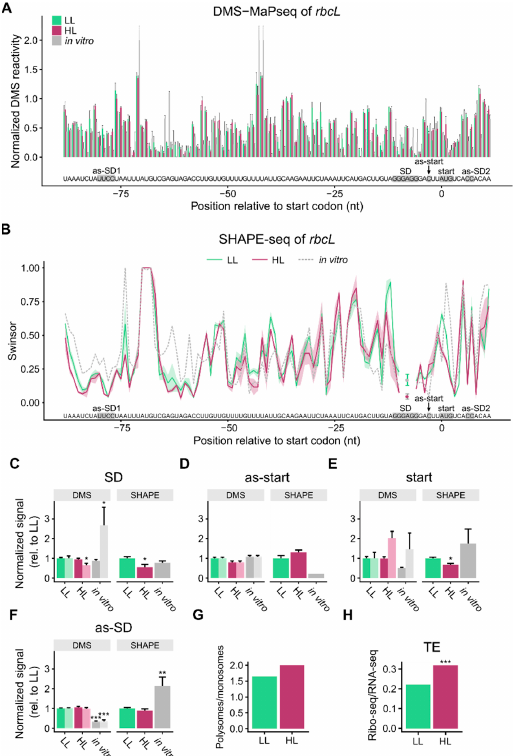
Figure 3. mRNA secondary structure changes in the translation initiation region of rbcL : ( A ) DMS probing of RNA from young, 17–18-days-old plants exposed to low light (LL, light green), high light (HL, dark red), and of in vitro-folded RNA (gray). Normalized DMS reactivities are shown (compare Figure 1). The error bars indicate the mean standard error. The start codon (start), Shine-Dalgarno sequence (SD), and sequences that can bind the start codon (as-start) and the SD (as-SD1 and as-SD2) are marked. One portion of the SD can bind to a sequence in the coding region (as-SD2), the other one to a sequence upstream in the 5 ′ UTR (as-SD1). A comparison of the DMS-probed RNA with a water-treated control is shown in Supplemental Figure S4B. ( B ) SHAPE analysis (NAI-N 3 probing) of RNA from young leaf tissue obtained from seven-week-old plants presented as swinsor normalized termination counts. The shaded areas around the lines indicate the mean standard error. Positions − 9 and − 7 were not analyzed, because for at least one of the LL or HL samples the swinsor value was missing. ( C ) Average incidence of structure at the Shine-Dalgarno sequence (SD) as shown by DMS and SHAPE values normalized to the low light values. The darker colored columns represent the more reliable reactivities at adenosines/cytidines, the columns in lighter colors are the reactivities at all four nucleotides. Asterisks here (and in ( D – F )) indicate statistically significant changes compared to LL ( p -values calculated with the Wilcoxon rank sum test; * = p < 0.05, ** = p < 0.01, and *** = p < 0.001), error bars indicate mean standard error. ( D ) Average mRNA secondary structure at the nucleotide binding the start codon (as-start). ( E ) Average structure at the start codon (start). ( F ) Average structure at the sequences binding the SD (as-SD1 and as-SD2). ( G ) Change in translation in 17–18-days-old plants (polysome fractions/monosome fractions, Figure S1). ( H ) Change in translation efficiency (ratio footprints/transcript levels, Figure 4) in young leaves of seven-week-old plants. Asterisks indicate statistically significant changes compared to LL (calculated with RiboDiff; *** = p <